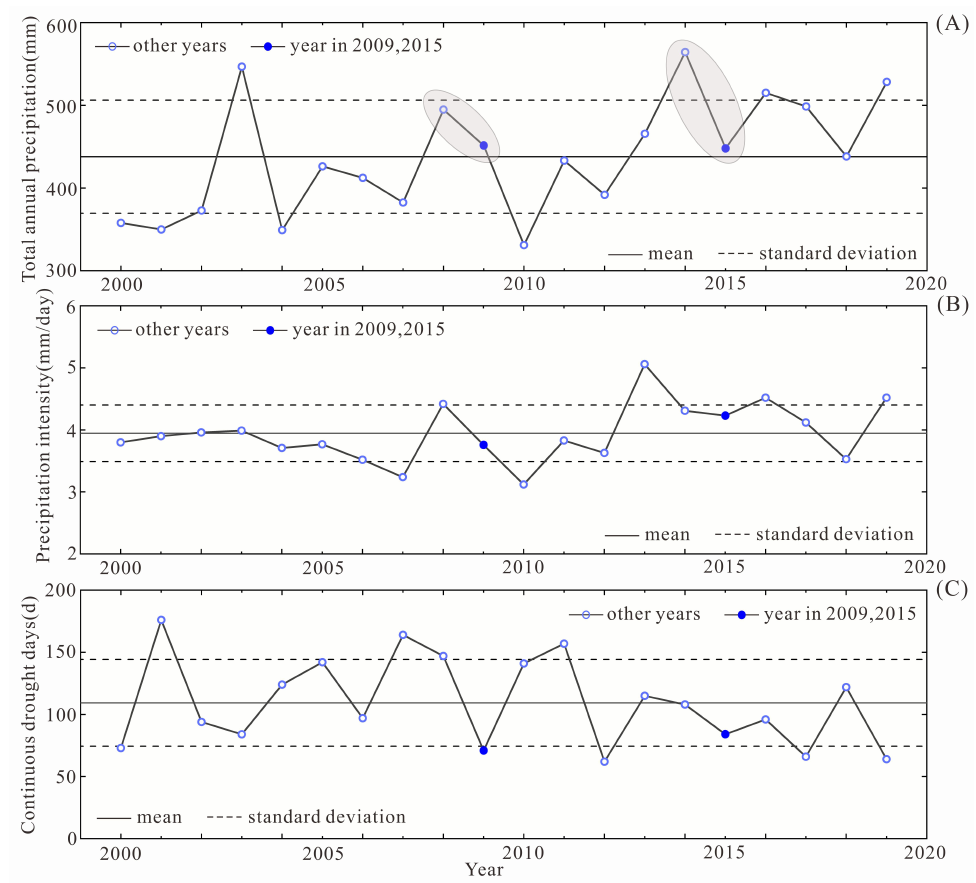
Figure 6. Variations of precipitation during 2000–2019: ( A ) variations in annual precipitation, ( B ) pre- cipitation intensity, ( C ) number of consecutive drought days in a